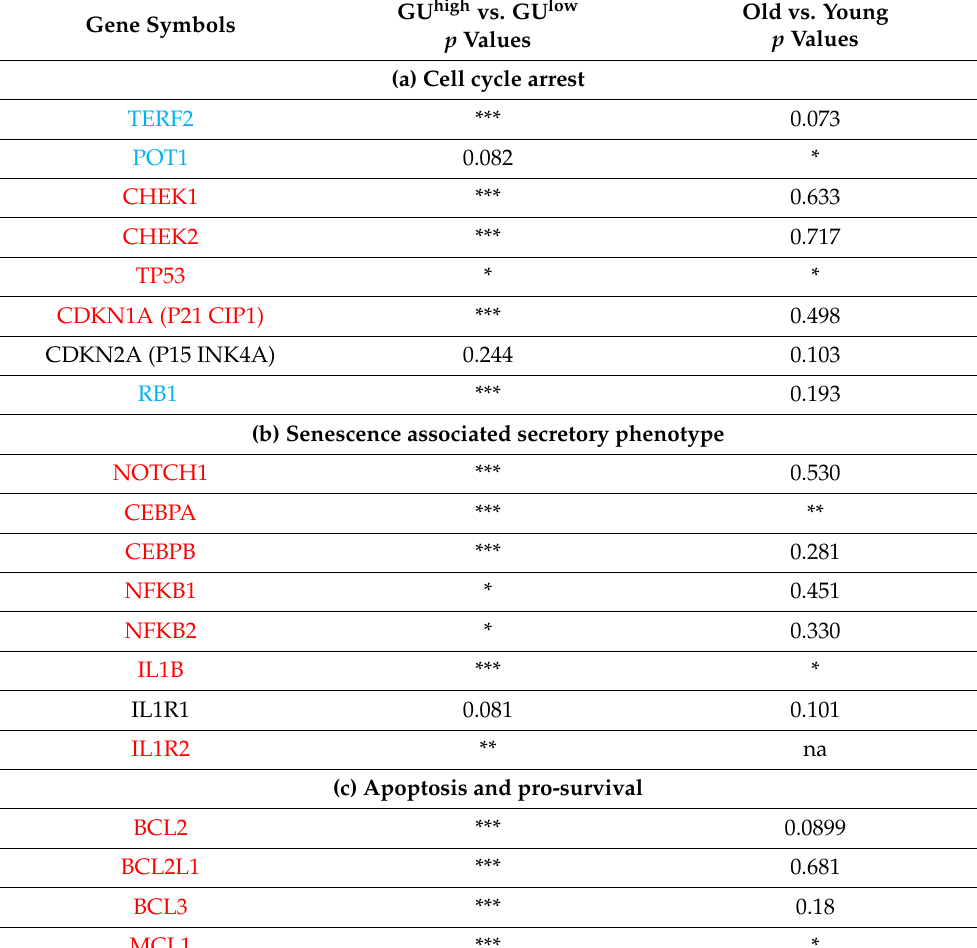
Table 2. Differential expressions of genes involved in biological processes. (a) Cell cycle arrest; (b) senescence-associated secretory phenotype; (c) apoptosis and pro-survival. Gene